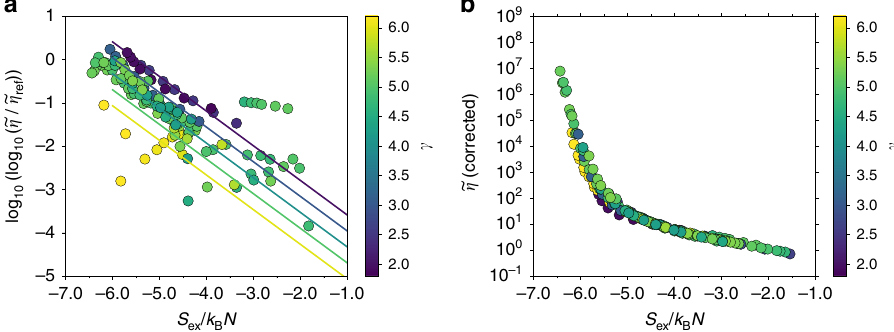
Fig. 8 Correcting for the deviation from universality. a The correction plotted as a function of S ex / k B N , where the colored lines are isolines of γ = (2, 3, 4, 5, 6). Shown are data with e η > e η . b The corrected viscosities using Eq. (7) as a function of S ex / k B N . A better collapse is obtained compared to Fig. ref